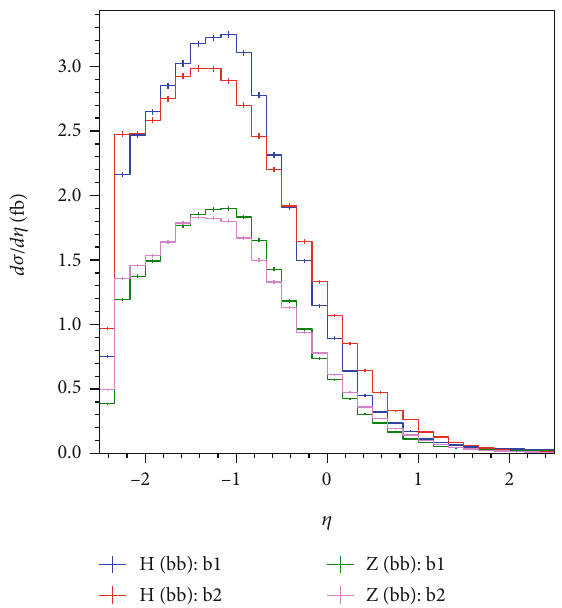
Figure 4: The invariant mass distribution of two b-tagged jets for (cid:2) b (cid:2) b the signal H ⟶ b and background Z ⟶ b process, after requiring p b T > 40 GeV and − 2 : 5 < η b < 1 , at a 100 – 3000GeV electron-muon collider. Table 1: Summary of collider parameters and the